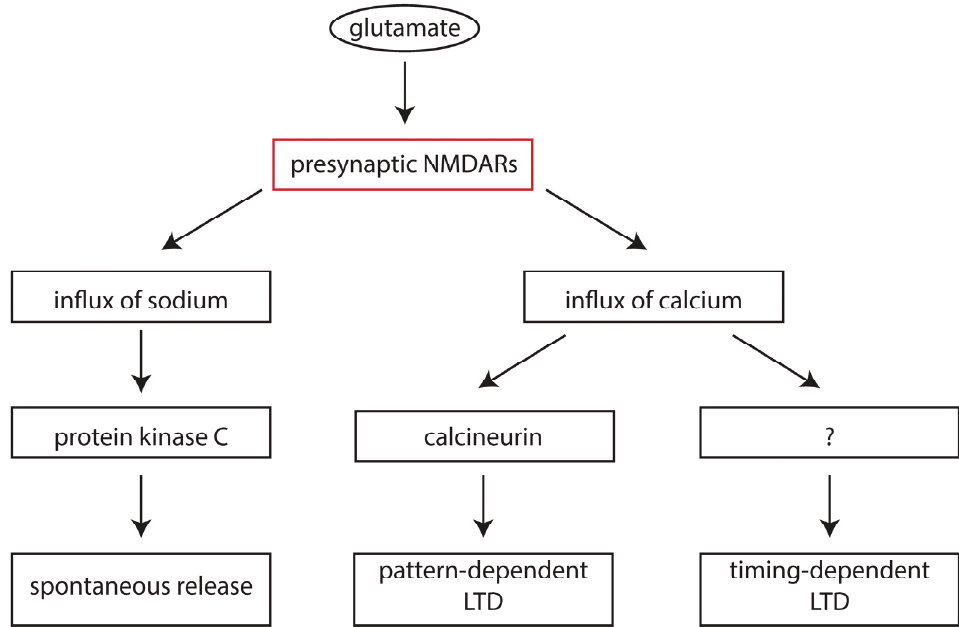
Figure 2. Signaling mechanisms downstream of presynaptic NMDA receptor activation. Presynaptic NMDARs control spontaneous glutamate release, timing-dependent LTD and pattern-dependent LTD through three distinct signaling pathways. Facilitation of spontaneous release does not depend on calcium influx. Timing-dependent LTD appears to require coincident activation of presynaptic CB1 receptors and glutamate release from